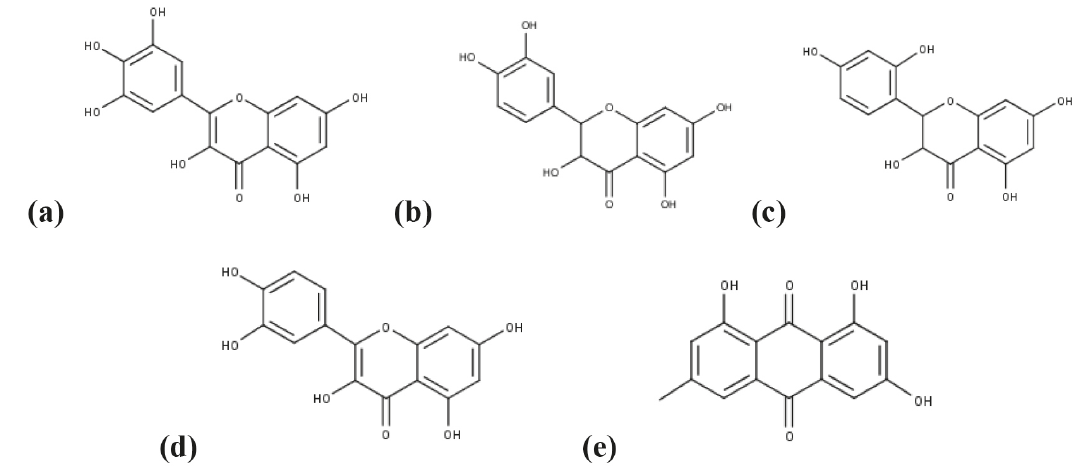
FIGURE 36 - Chemical structures of (a) myricetin, (b) quercetin, (c) morin, (d) luteolin, and (e)